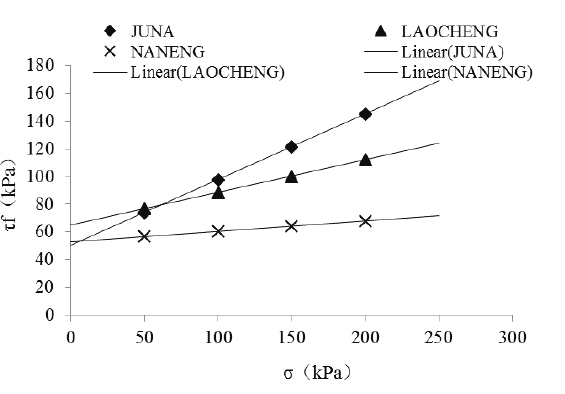
Figure 8: Comparison of shear strength of dry red soil with different